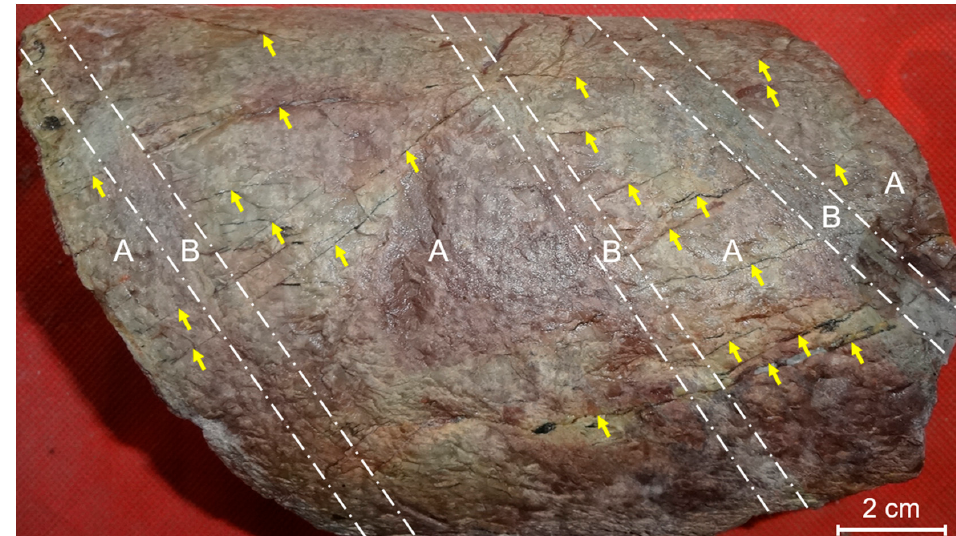
Figure 15. Tectonic fractures in the cores of Well R15, depth 2598.08 m (8523.88 ft). The fractures are mainly developed in layer A and end at the interface between separate layers A and B.